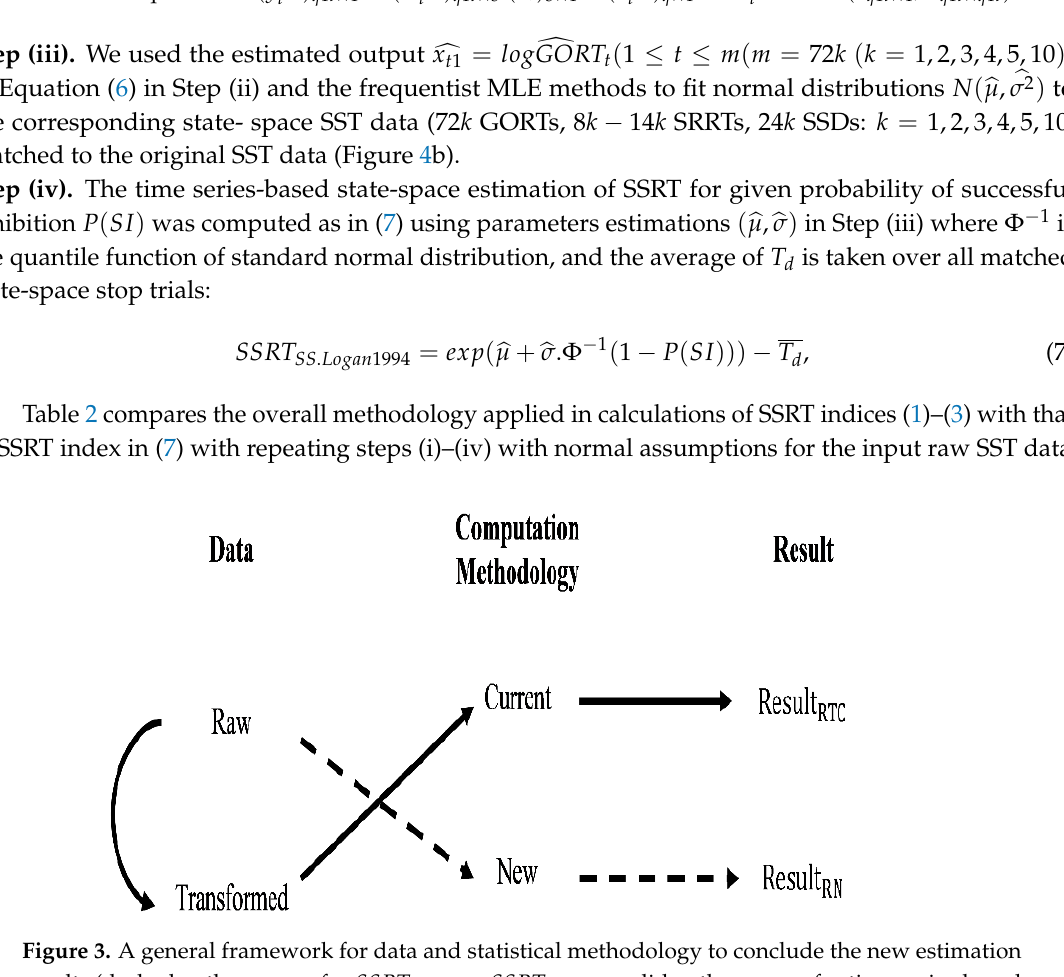
Figure 3. A general framework for data and statistical methodology to conclude the new estimation results (dashed path: process for SSRT Weighted , SSRT Mixture ; solid path: process for time series-based SSRT SS . Logan 1994 ).